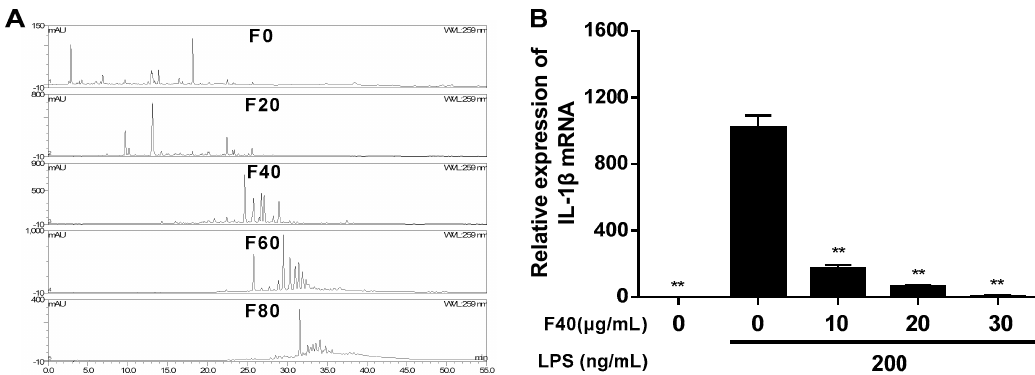
Figure 1. ( A ) HPLC characterization of the five fractions. A total of 10 µ L each sample (1 mg / mL) was injected and analyzed using a Dionex UltiMate TM 3000 HPLC system with photodiode array detection (PAD) at 259 nm. A Symmetrix ODS-RC18 (25 × 4.6 mm, 5 mm) HPLC column protected with a Phenomenex security guard column (C18, 4 × 3.0 mm) operated at 30 ◦ C was used, and the flow rate was maintained at 1 mL / min. The elution solvents were acetonitrile (a) and 0.1% acetic acid (b). Samples were eluted according to the following gradient: 0–35 min 30% a isocratic, 35–45 min 30% to 40% a, 45–55 min 40% a isocratic, and finally washing and recondition of the column. ( B ) Relative expression of IL-1 β mRNA after treatment with F40. RAW264.7 cells were pretreated with di ff erent concentration of F40 for 1 h and then treated with 200 ng / mL LPS for 6 h. Total RNA was extracted and genes expression level were analyzed by RT-PCR in triplicate. The expression level of each gene was normalized to glyceraldehyde-3-phosphate dehydrogenase (GAPDH) mRNA. Data are expressed as mean ± SD ( n = 6). ** p < 0.01 vs. LPS treatment group.